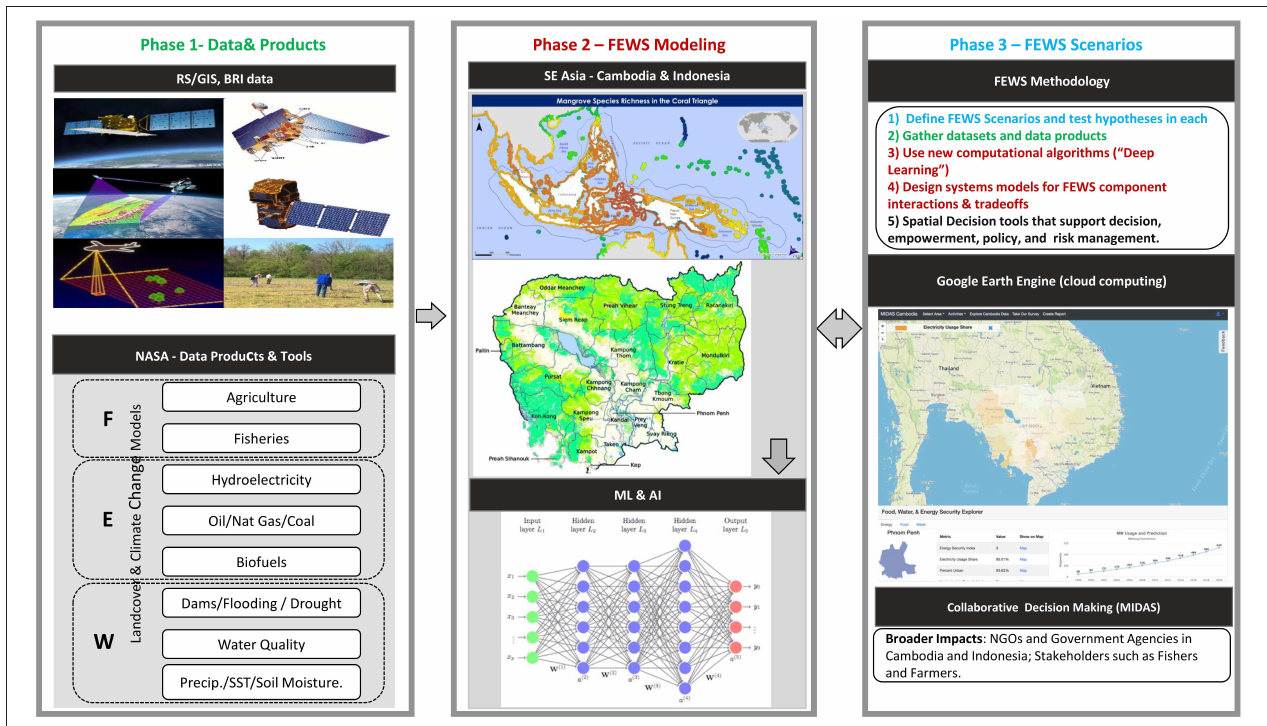
FIGURE 3 | The general framework for FEWS studies in SE